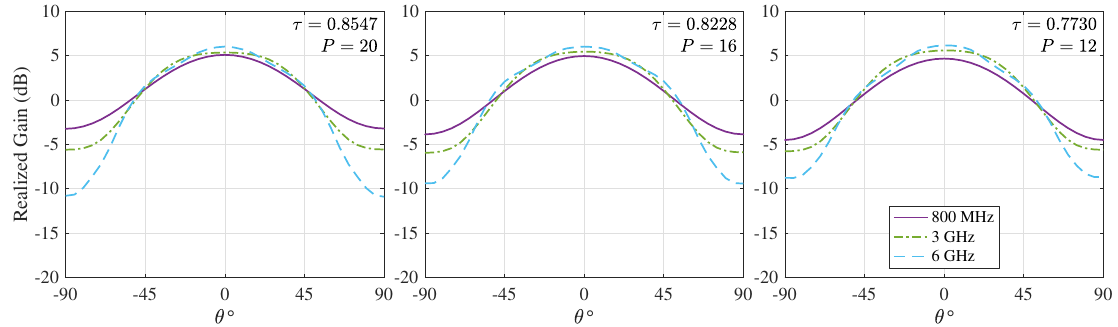
Figure 4. Reflection coefficient and boresight realized gain vs. frequency for the sinuous antennas investigated.